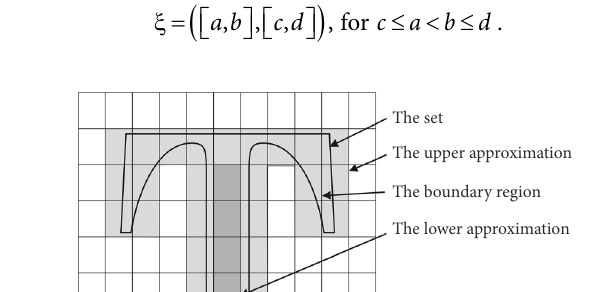
The set The upper approximation The boundary region The lower